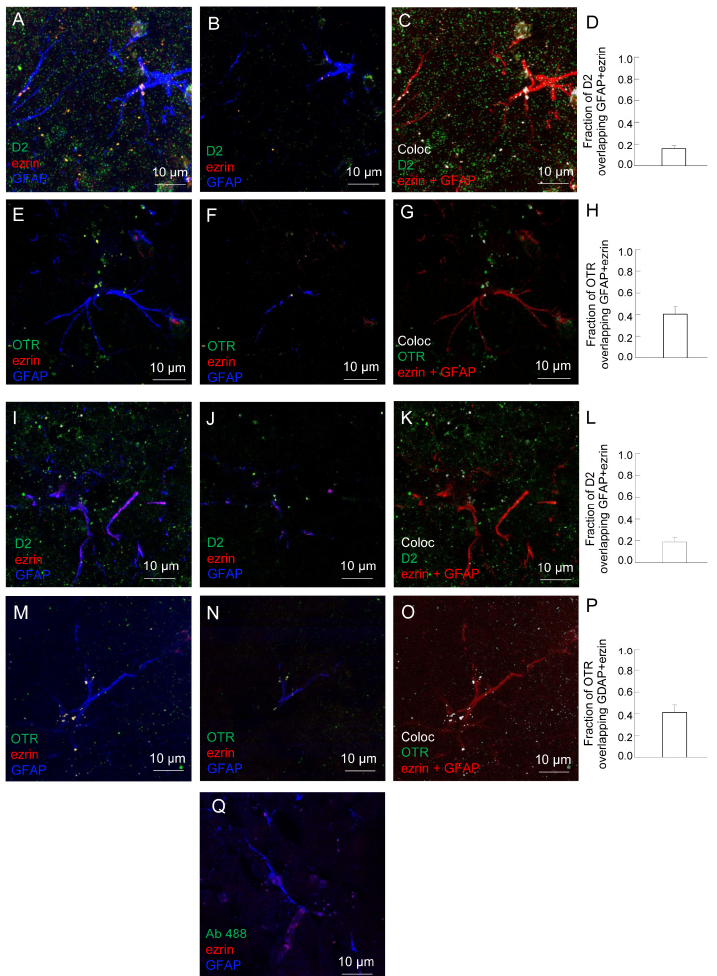
Figure 5. Striatal astrocytes express OT receptors and D2 receptors. Representative confocal im- ages showing the presence of the OTR and D2 receptors in rat ventral ( A – H ) or dorsal ( I – P ) stria- tum. Triple immunofluorescence analysis was conducted using primary antibodies: anti-D2 re- ceptor ( A – C , I – K ), anti-OTR ( E – G , M – O ), anti-GFAP and anti-ezrin ( A – Q ) in rat hemibrain slices. ( A , E , I , M ) The merge of the maximum intensity projections of a representative field (65 × 65 µ m; z 8–12 µ m) is shown; GFAP (blue), ezrin (red), D2 (green, A – C , I – K ) or OTR (green, E – G , M – O ). ( B,D , F , H ) Merged confocal images of a single z stack of the image shown in ( B , F , J , N ). ( C , G , K , O ) Co-localized maps of the same images shown in ( A , E , I , M ), and in which ezrin and GFAP were merged and are red, while the receptors are green. The white dots are the co-localized pixels. The bars ( D , H , L , P ) indicate the fractions ( ± SEM of n = 3 fields from three different preparations) of D2 or OTR expressed on GFAP, ezrin, or GFAP + ezrin positive astrocytes. ( Q ) A representative control image acquired on slices in which the primary antibody for OTR or D2 was omitted. GFAP, glial fibrillary acidic protein; OTR, oxytocin